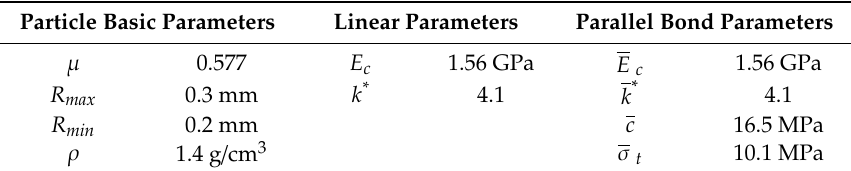
Table 3. Microscopic parameters used in the PFC2D model.